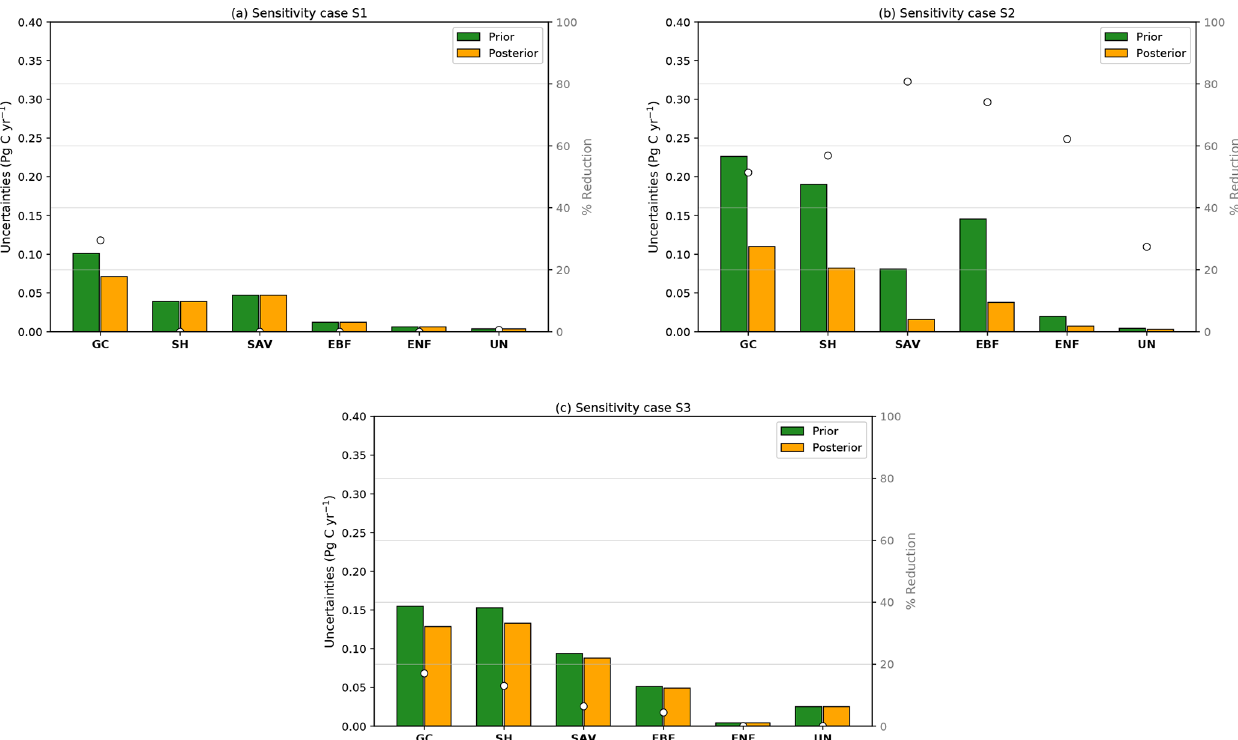
Figure 9. Sensitivity experiments for the prior and posterior uncertainties (in PgCyr − 1 ) aggregated over six different classes over the Australia domain using MODIS Land Cover Type Product